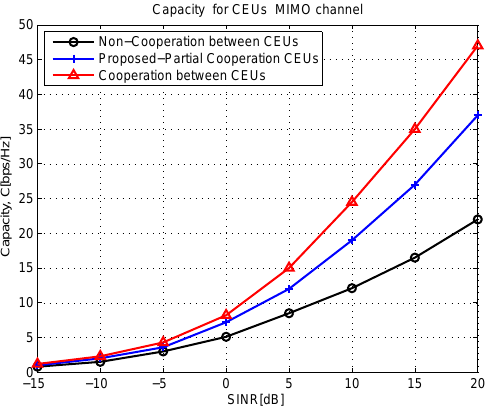
Figure 8. The capacity for cell-edge multiuser multiple-input-multiple-output interference